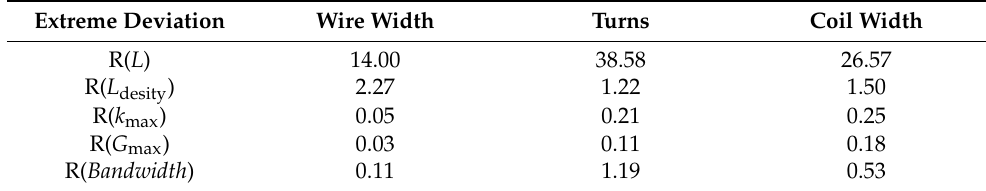
Table 3. Extreme deviation analysis of solenoidal transformer with air core.